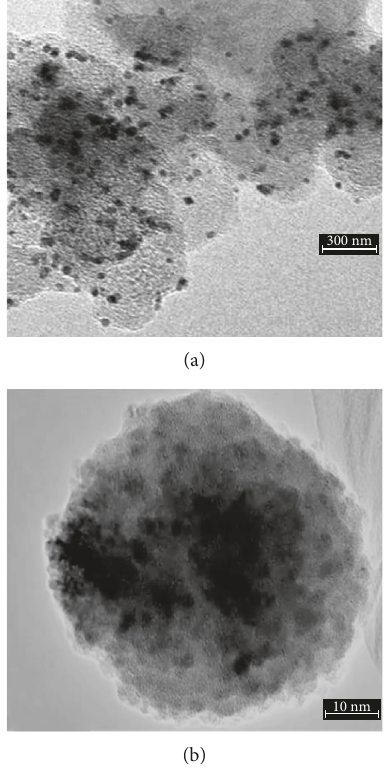
Figure 5: TEM micrographs of the collected